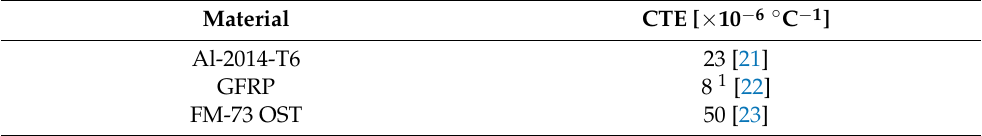
Table 3. Coefficient of thermal expansion (CTE) of the different materials